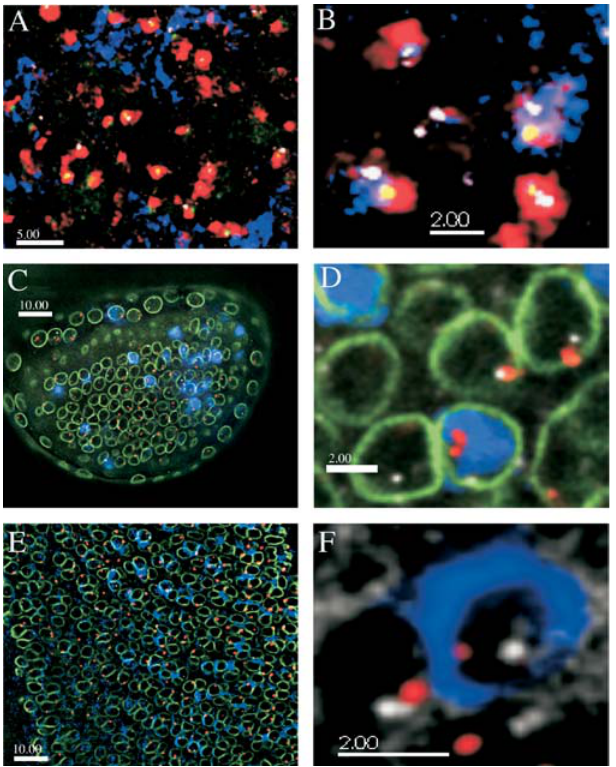
Figure 1. Gene Expression and LRCIs Color images show combined FISH–gene expression results for each of the three lines studied. (A and B) bw D adult eye tissue. brown -expressing cells with pigment are blue, DAPI is red, single-copy FISH marking the brown locus is white, and heterochromatic single is green. (A) Wider view of eye. (B) Close- up view showing two expressing cells at right and lower left, and one silenced cell at the lower right. (C and D) In(3L)BL1 eye disk tissue. Blue is anti-beta-galactosidase staining, green is anti-lamin staining, white is single copy FISH, red is heterochromatic FISH signal. (C) Wide-angle view of disk. (D) Close- up view showing silenced cells and expressing cells (blue in nucleus). (E and F) In(1) rst 3 eye disk tissue. Blue is anti-White staining, green is anti-lamin, red marks heterochromatic FISH signals, and white is single-copy FISH to the white gene. (E) Wide-angle view of disk. (F) Close-up showing expressing cell ringed by White protein and silenced cell nearby with no